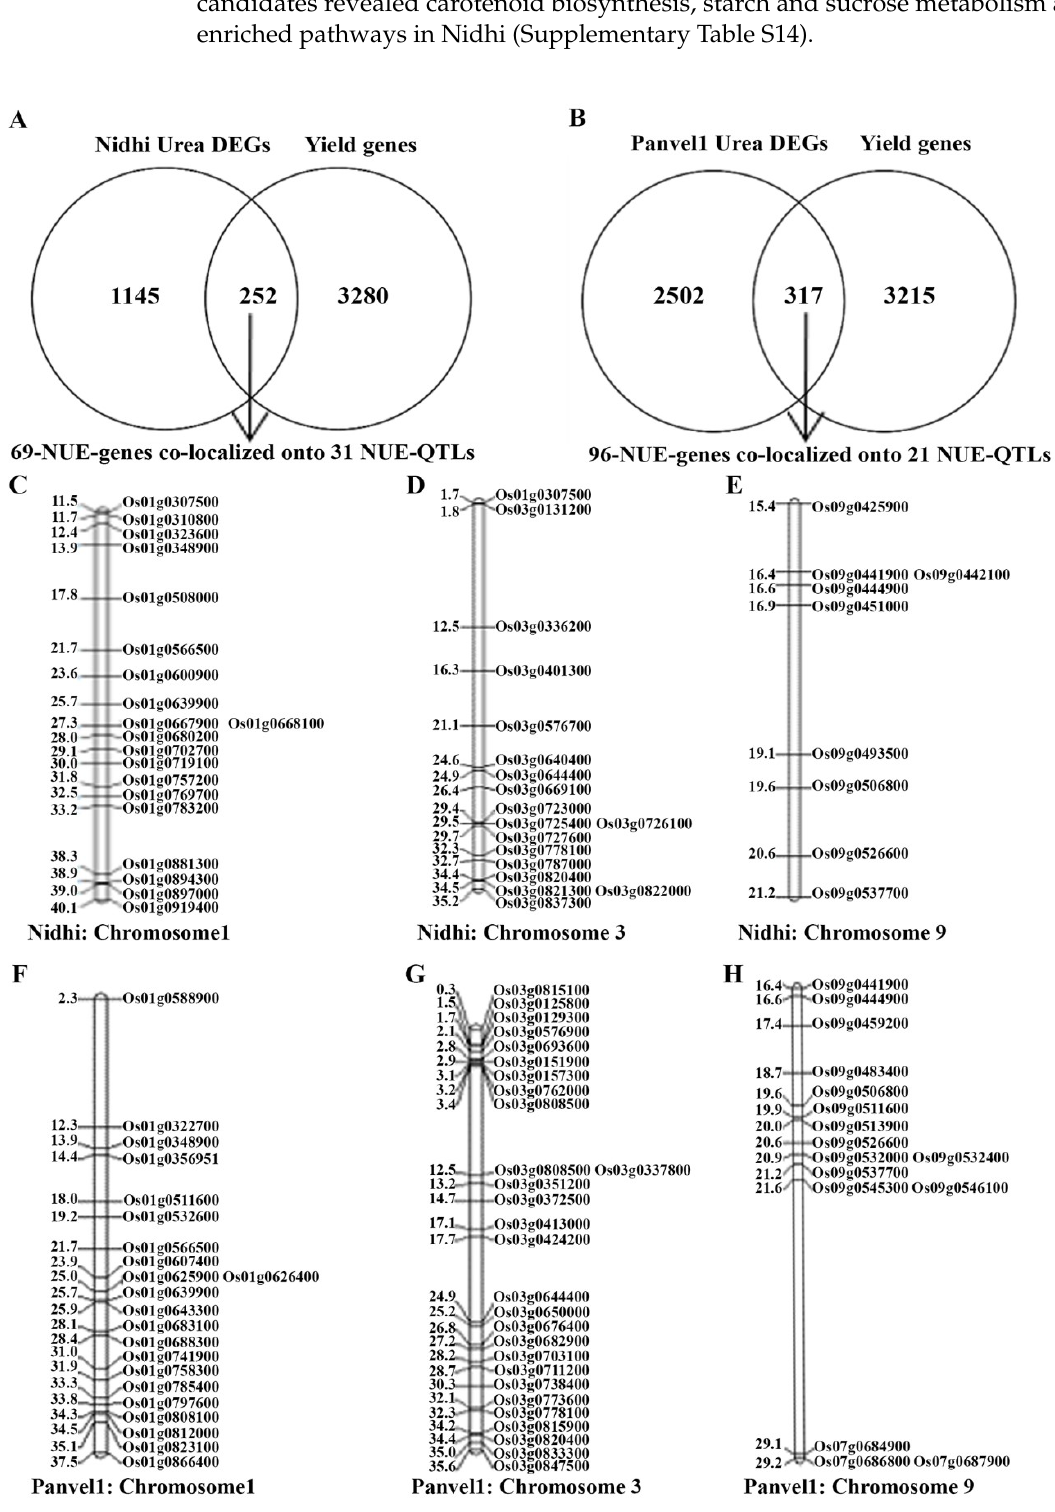
Figure 3. Venn selection for NUE genes (N-responsive and yield-related genes) in ( A ) Nidhi urea and ( B ) Panvel1 urea. Representative figures for physical location of NUE candidates located on chromosomes 1, 3 and 9 in ( C – E ) Nidhi urea and ( F – H ) Panvel1 urea. Gene ID is given on the right side and the physical location of genes is given on the left side of the map (in Mb). This revealed 96 unique urea NUE genes colocalized to 21 NUE-QTLs in Panvel1. They were mostly on chromosomes 3 (28), 1 (22) and 9 (16), followed by 10 genes on chro- mosome 5, 6 (7), 7 (5) and 4 genes on chromosome 3 (Figures 3F – H, Supplementary Table S15). Process annotation of these 96 urea NUE candidates in Panvel1 revealed circardian